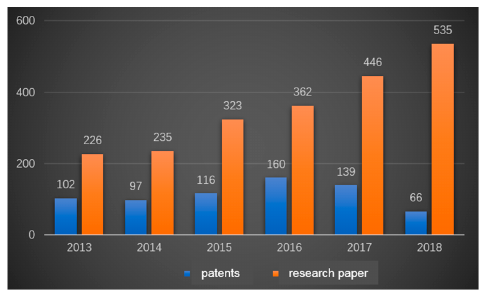
Figure 1. Patents and papers on terahertz applications published annually from 2013 to 2018.